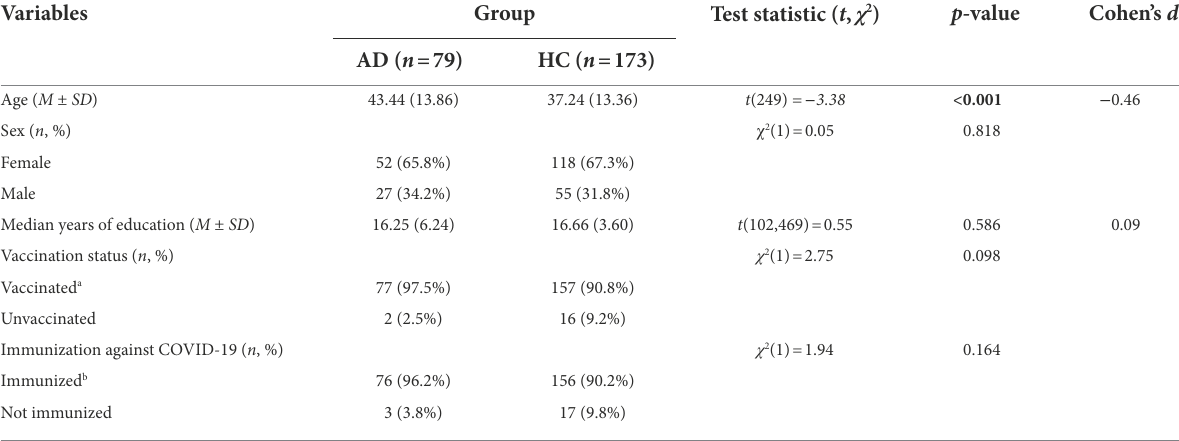
TABLE 2 Sociodemographic characteristics of individuals with affective disorder and healthy